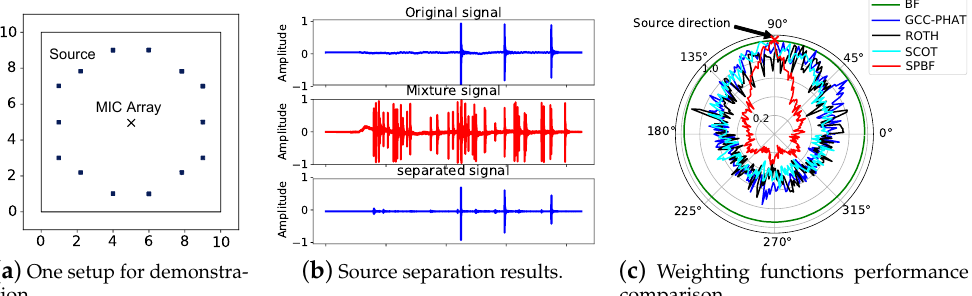
Figure 2. Setup and results. ( a ) shows the setup that has up to 14 different sound sources around our designed microphone array (12 mics) and these sources with a duration of 20 ∼ 50 ms are triggered simulatenously. ( b ) demonstrates that DUET is able to distangle multiple sources. ( c ) depicts that our proposed weighting function achieve better performance than other algorithms when there is only one input source at a relatively low